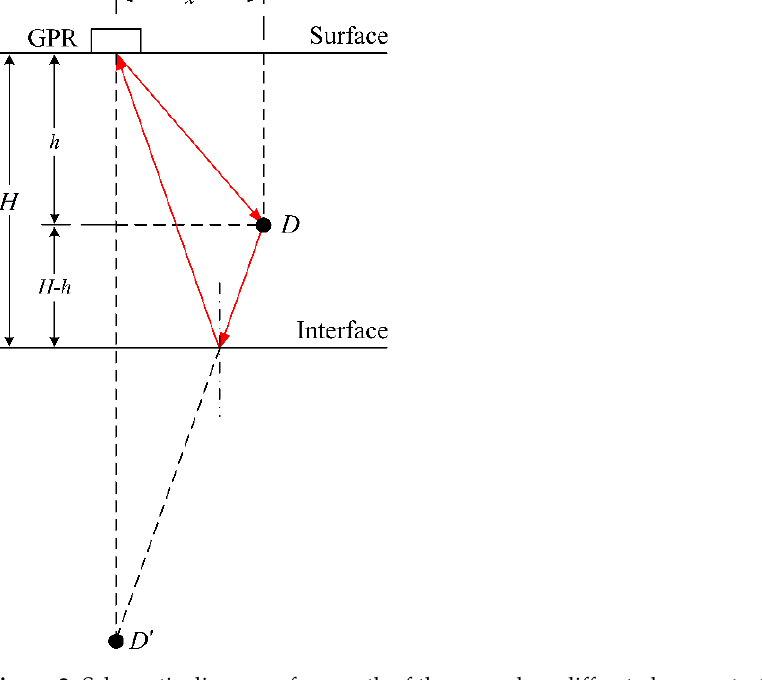
Figure 2. Schematic diagram of ray-path of the secondary diffracted wave starting from a point and interface in a layered homogeneous model.